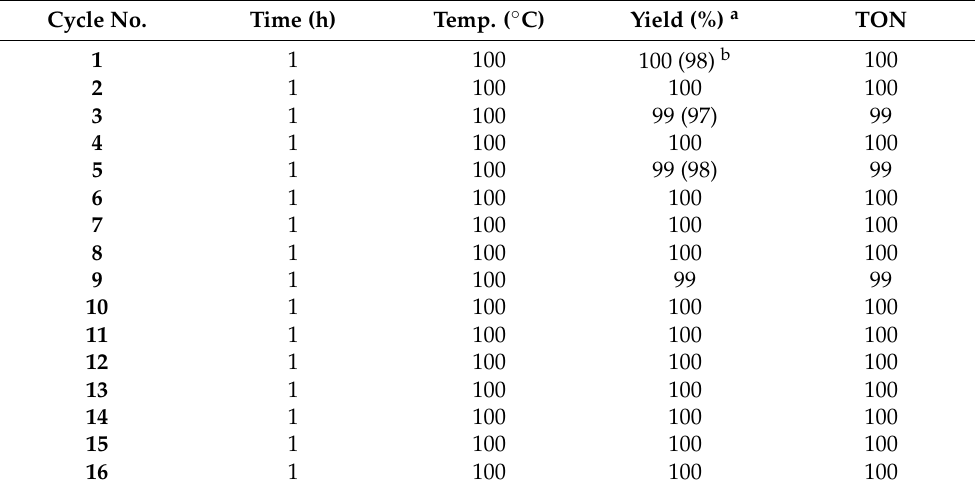
Table 2. Recycling results of A -catalyzed phospha-Michael addition of diisopropyl phosphite ( 1a ) with benzylidenemalononitrile ( 3 ) at 100 ◦ C. Cycle